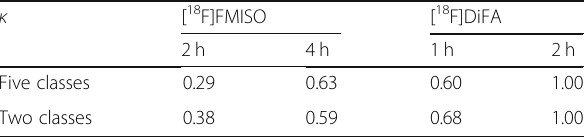
Table 6 κ value for PET/CT images